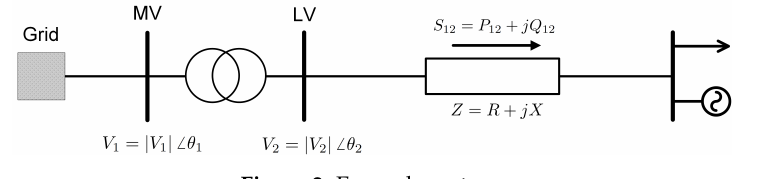
Figure 2. Example